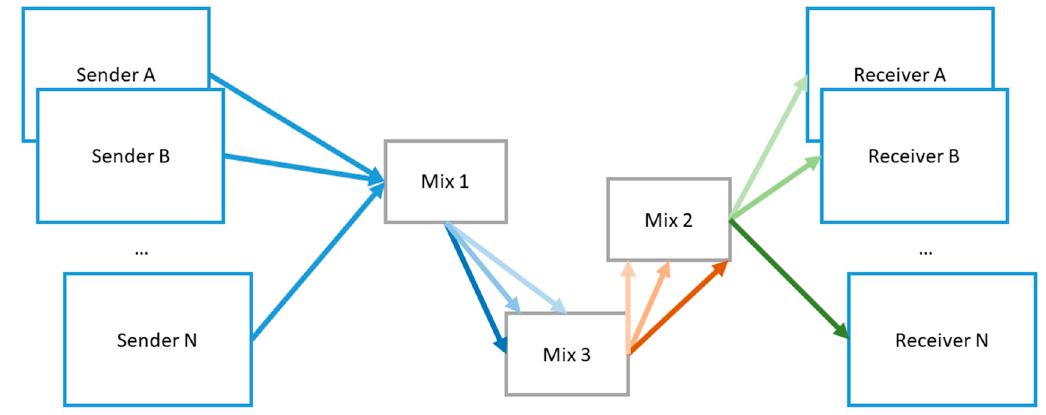
Figure 20. Conceptual overview of Mix Network offering sender anonymity